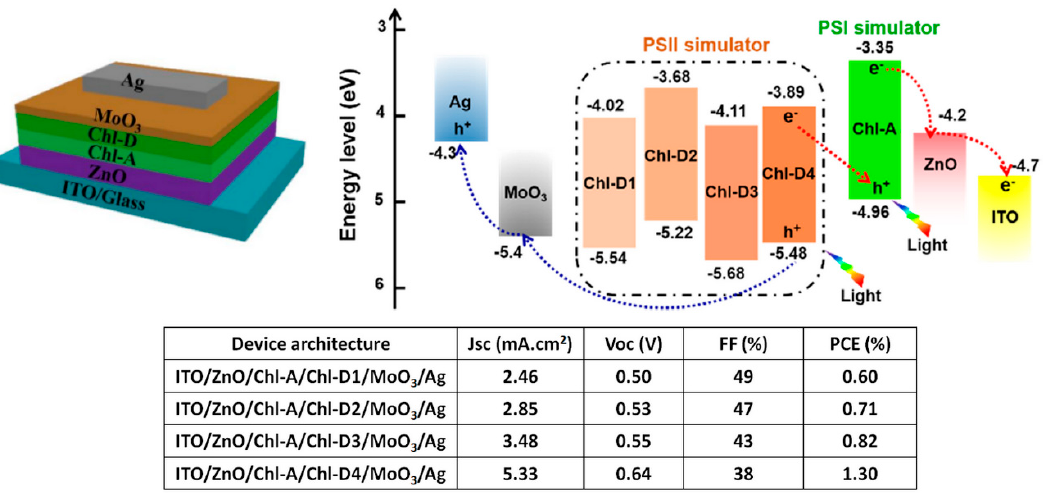
Figure 7. Schematic representation of device architecture and energy levels along with the device performances of all chlorophyll-derivatives active layer OSCs. Reprinted with permission from Reference [35]. Copyright 2018 American Chemical Society.